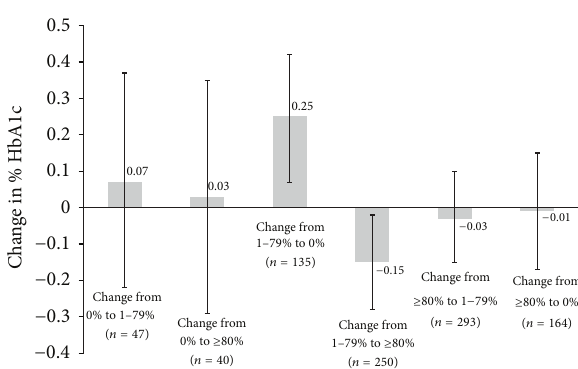
Figure 2: Percentage point change in HbA1c between first HbA1c measured 6–12 months after metformin initiation and last HbA1c of observation period measured 3–21 months later by change in category of Biologic Response Based Proportion of Days Covered where no change is the reference group. Data are for the total sample (Analysis 2). Error bars represent 95% confidence intervals.